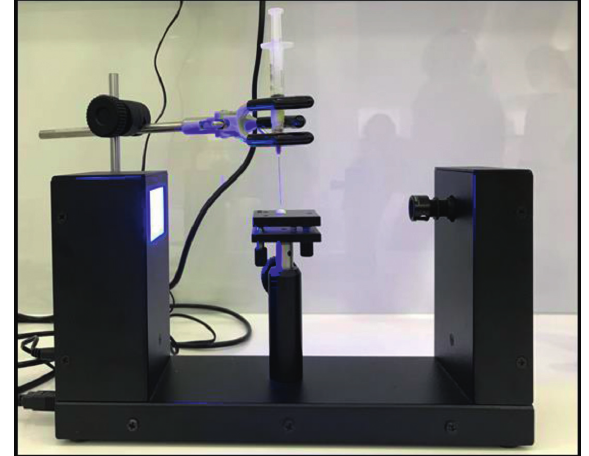
Figure 2: A contact angle goniometer used to measure the contact angle.